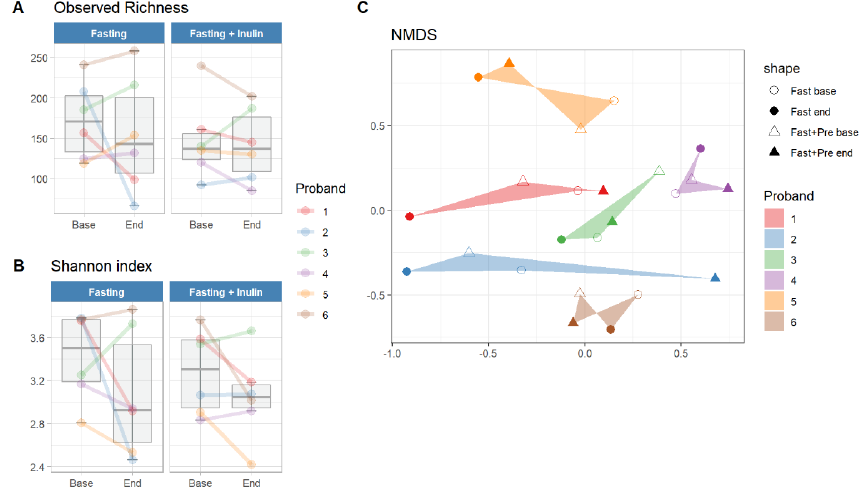
Figure 2. Changes in human gut microbial composition after fasting intervention and inulin intake. ( A , B ) Alpha diversity measures before and after fasting intervention. The lines and dots are colored according to the identities of the participants and show the individual changes in the gut microbiome community. ( C ) Beta diversity of bacterial samples based on Bray-Curtis distances and visualized using Non-Metric Multidimensional Scaling (NMDS). Colors correspond to participant identities and shapes to intervention phases.